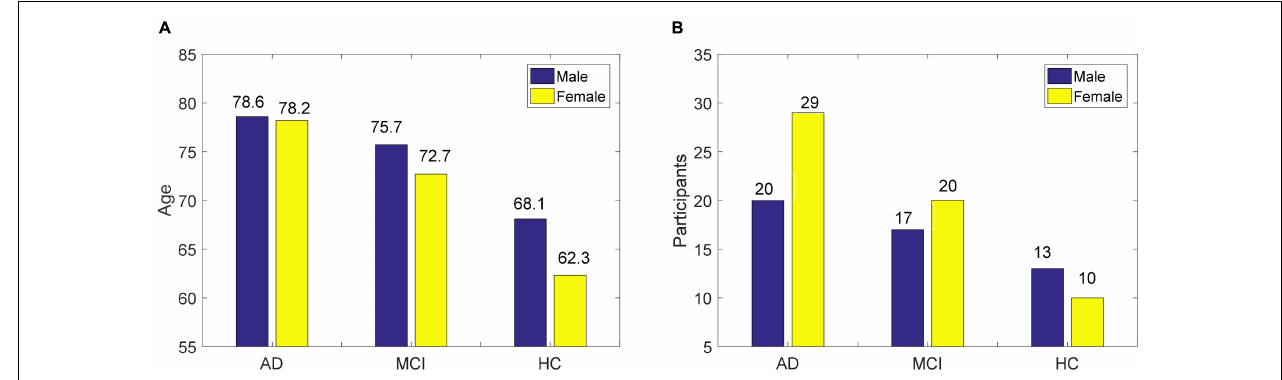
FIGURE 1 | The basic information of EEG data used in this study, (A) age of men and women, and (B) proportion of